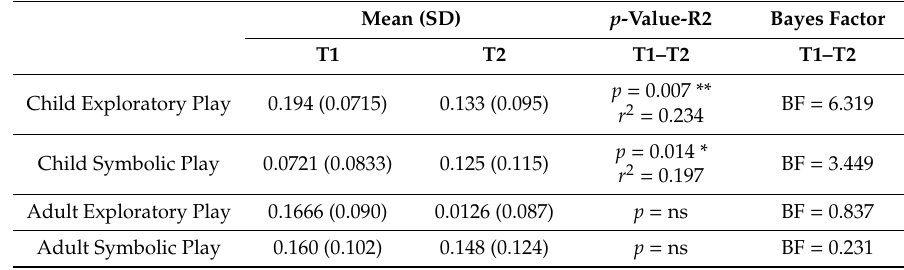
Table 6. Descriptive and Inferential Statistics for Play